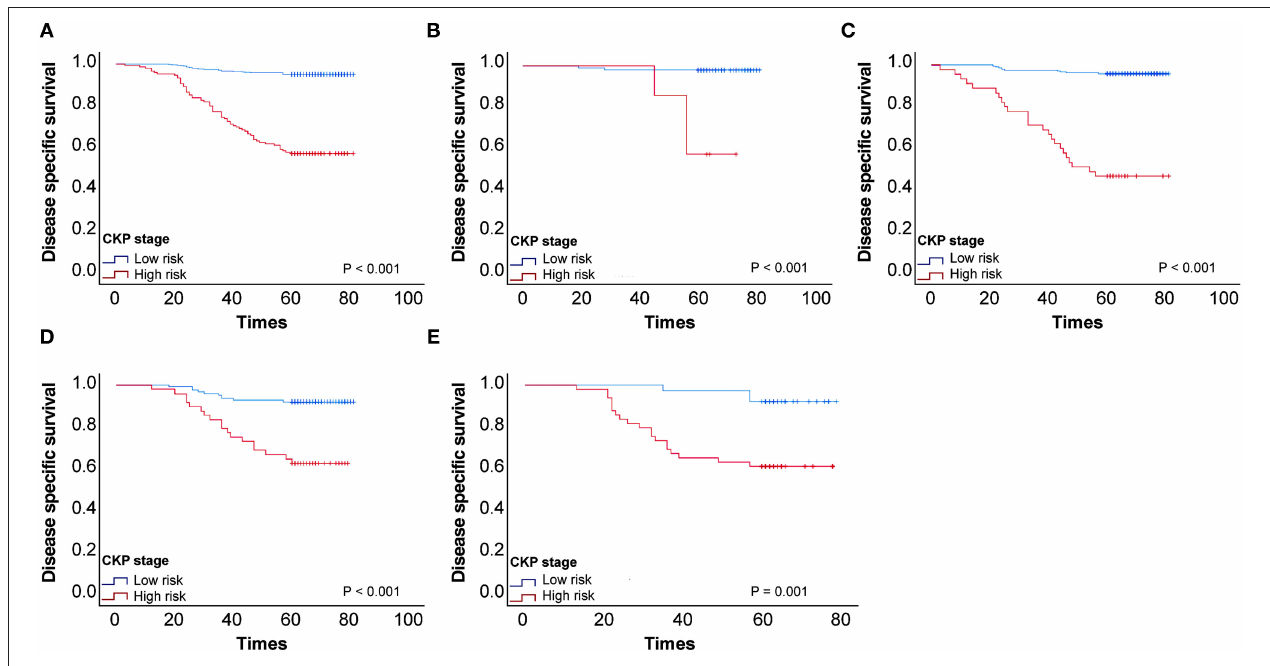
FIGURE 4 | (A) Kaplan–Meier univariate analysis with CEA-Ki-67-pathologic subtype (CKP) values for patients with stage I pulmonary adenocarcinoma, (B) Kaplan–Meier univariate analysis with CKP values for stage I sub-stages IA1, (C) Kaplan–Meier univariate analysis with CKP values for stage I sub-stages IA2, (D) Kaplan–Meier univariate analysis with CKP values for stage I sub-stages IA3, (E) Kaplan–Meier univariate analysis with CKP values for stage I sub-stages IB.